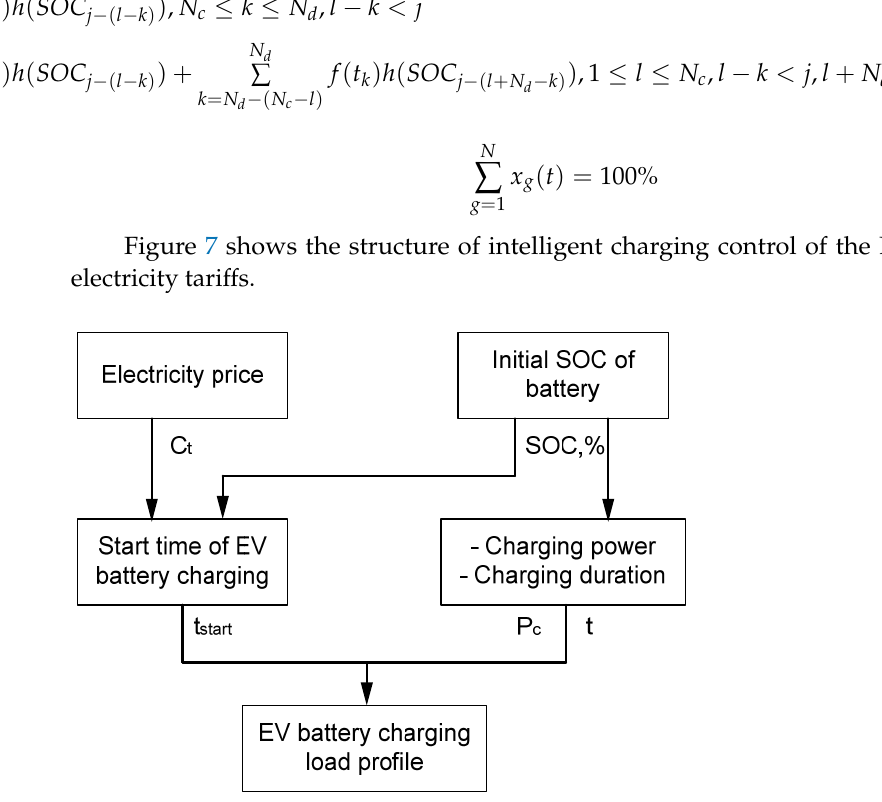
Figure 7. Structure of intelligent EV charging control. The model of a distribution electrical grid with normal and electric mobile loads is shown in Figure 8. The proposed model consists of the distributed electrical grid powered by an energy source, the transformer, the residential load (offices/small businesses), and the CSs themselves. The situational algorithm is used to simulate the CS operation connected to the electrical grid with a limited power supply. This option of connecting the CS to the electrical grid is the most common case. The system model for studying the effect of EV charging for twenty-four hours is implemented in MATLAB Simulink. The general view of the simulated system is shown in Figure